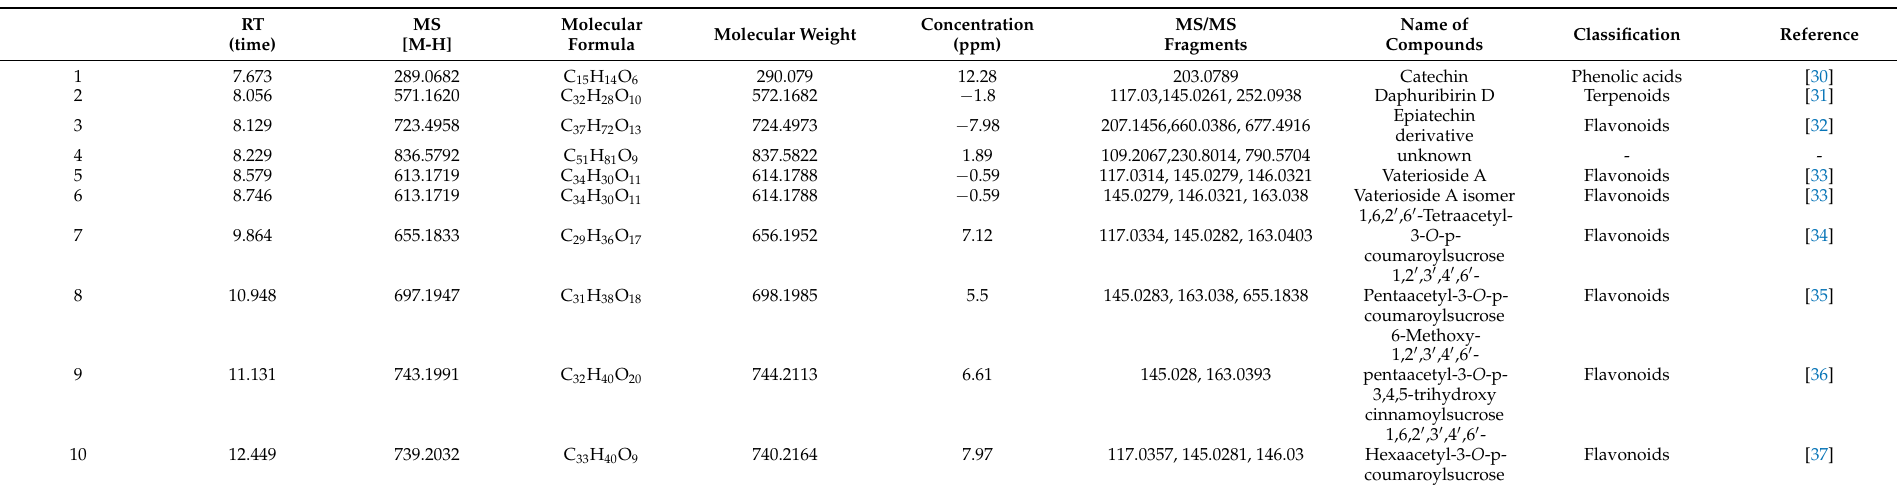
Table 2. Identified or tentatively identified compounds of the EtOAc fraction of M. lasiocarpa by